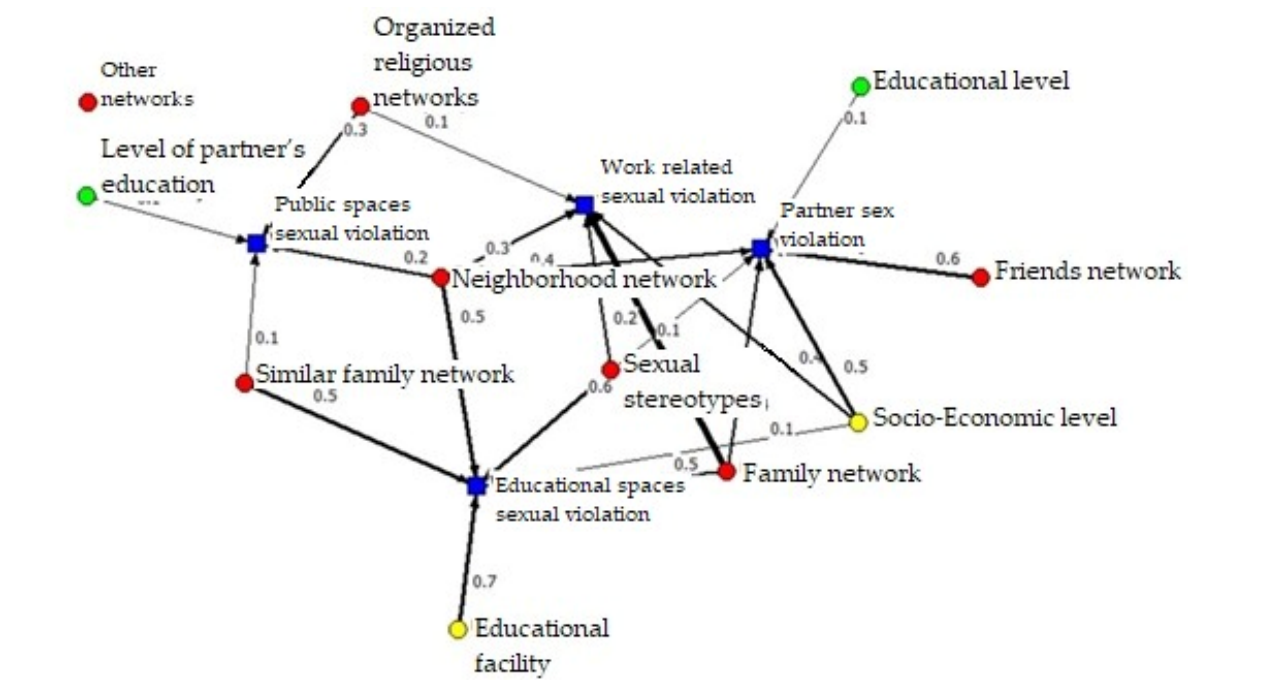
Figure 3. Protection network between capital and sexual violence.